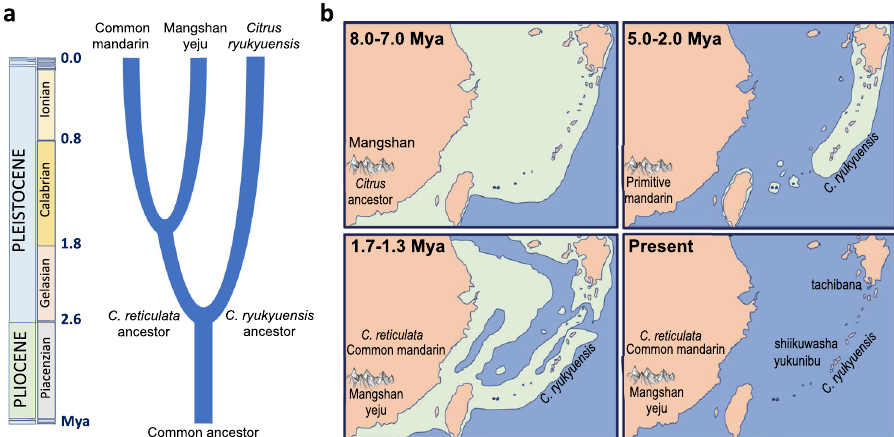
Fig. 2 Chronogram of east Asian mandarin citrus speciation and biogeography in the Ryukyu Arc and mainland Japan. a Population divergence times of C. ryukyuensis (2.2 – 2.8 Mya) and two subspecies of mainland Asian mandarins ( C. reticulata ): common mandarin and mangshanyeju (1.4 – 1.7 Mya). Extant common mandarins are recent admixtures with both mangshanyeju and pummelos. b Geological history of the Ryukyu Arc and evolutionary origins of east Asian citrus during four representative time periods: (1) initial radiation of citrus during the late Miocene 20 with subsequent dispersal to regions including Mangshan of the Nanling mountain range. The exact arrival time of primitive mandarins at Mangshan cannot be determined and could be as late as the Pliocene epoch (5.3 – 2.6 Mya) (top left), (2) geographical isolation and genetic divergence of C. ryukyueneis in the Ryukyu Arc from mainland Asian mandarins during early Pleistocene (top right), (3) divergence of mangshanyeju and common mandarins (bottom left), and (4) current distribution of east Asian citrus with C. ryukyuensis ancestry in the Ryukyu Arc and mainland Japan, as a result of distinct hybridization events with different migrant mainland mandarins (bottom right). (Maps are adapted from Kimura 25 with paleo-landmasses in light green.) Source data underlying Fig. 2a are provided as a Source Data fi le.